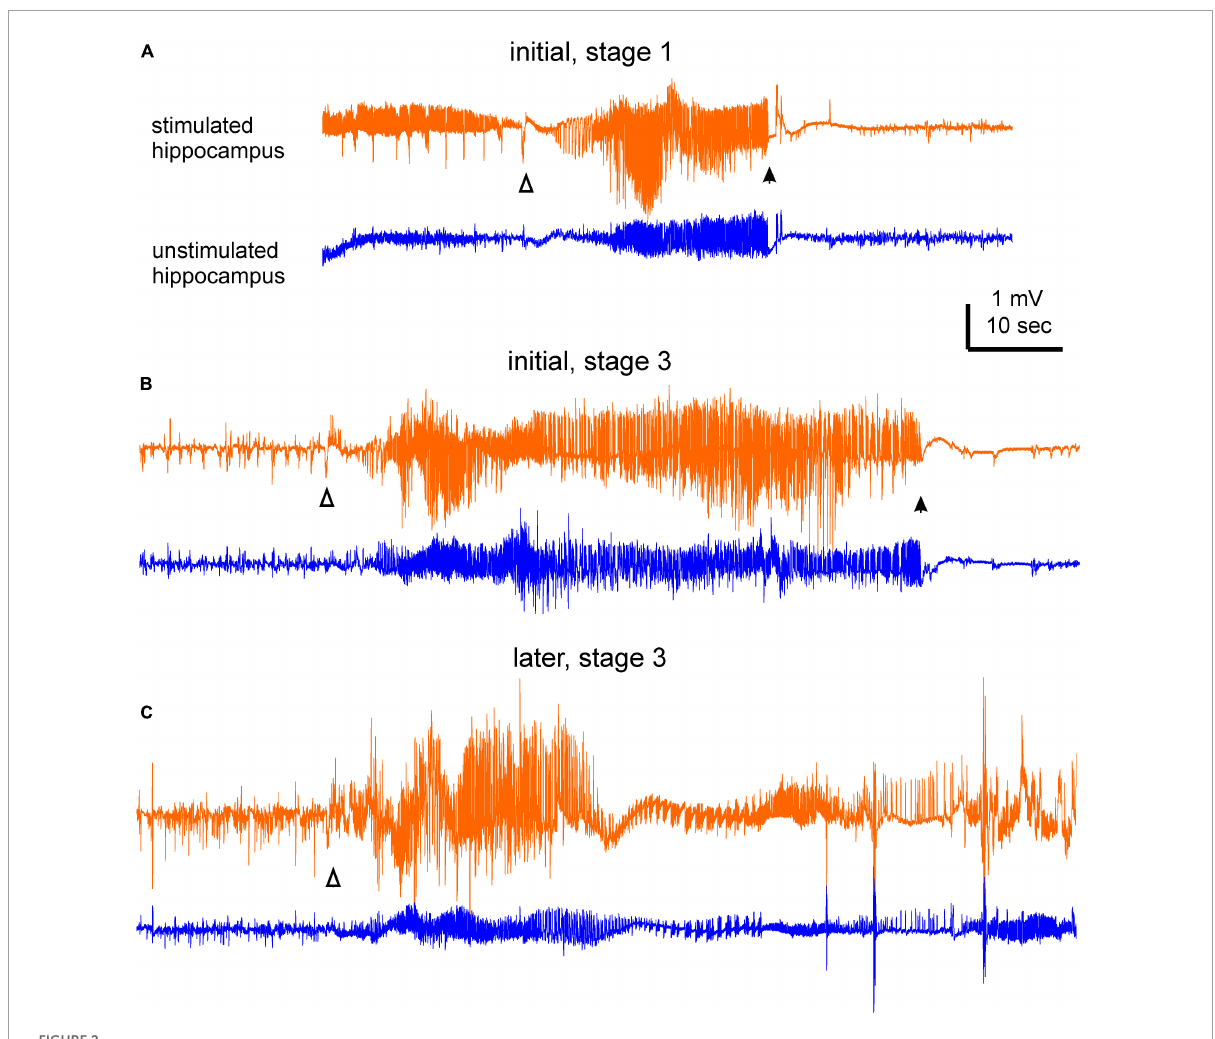
FIGURE2 Examples of electroencephalography (EEG) ictal discharges. Bilateral hippocampal discharges were collected from a mouse during the initial and late monitoring periods. Discharges in (A) were associated with a stage 1 motor seizure, and discharges in (B,C) were associated with stage 3 motor seizures. Discharge onset and termination were denoted by open and filled triangles, respectively. Note in (A) there were spike activities prior to the discharge onset of the stimulated hippocampus. In (C) discharge termination was difficult to determine due to post-ictal spikes and artifacts. Motor seizures corresponding to these discharges were presented in the part 2 of Supplementary Videos 1 – 3 .